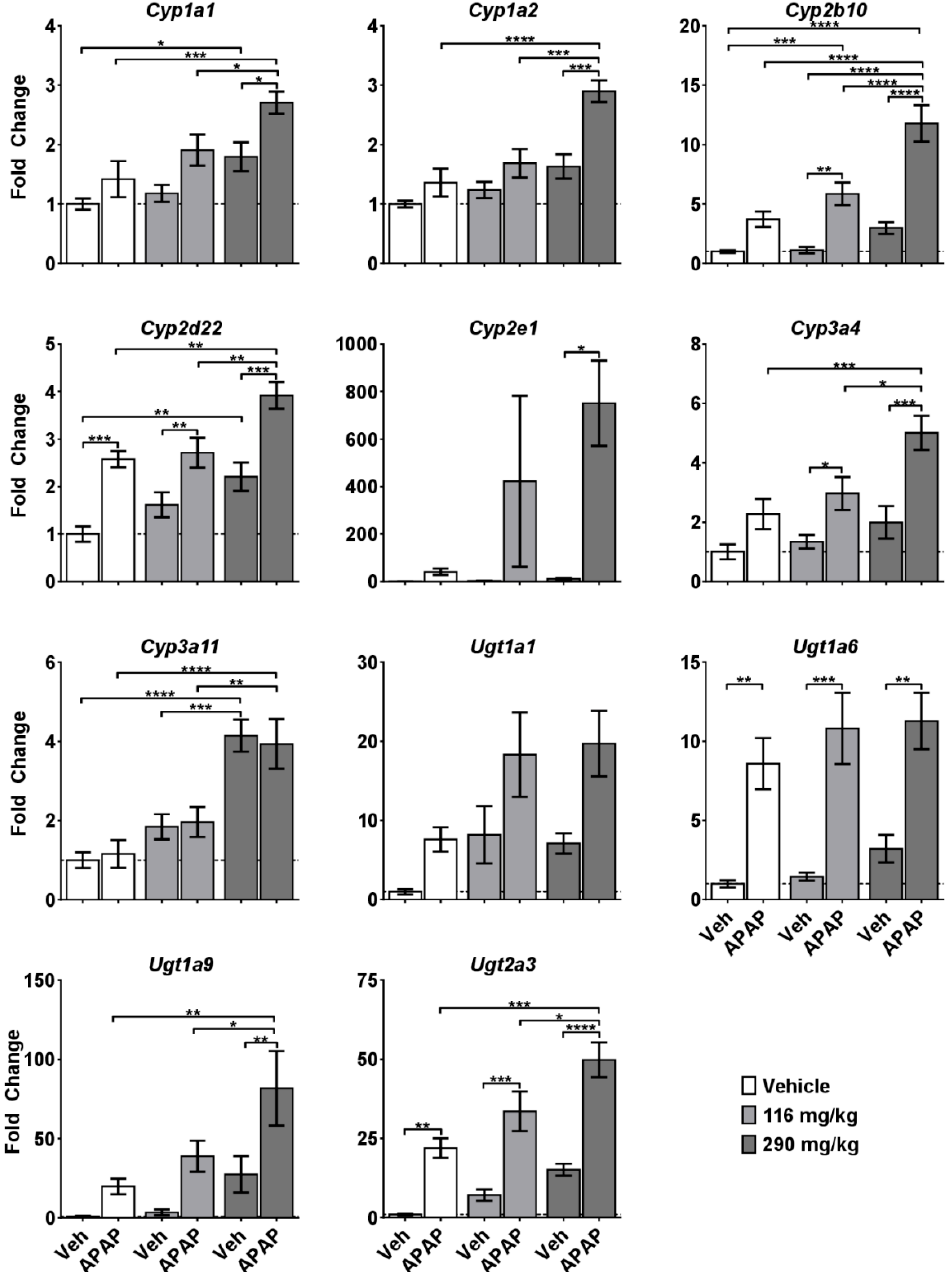
Figure 3. Effects of CRCE/APAP co-administration on intrahepatic expression of cytochrome P450s and UDP-glucuronosyltransferases. Livers were collected 5 h after APAP administration and gene expression was measured using the quantitative real-time (qRT) PCR. Veh ( n = 7); Veh + APAP ( n = 7); 116 mg/kg CBD ( n = 7); 116 mg/kg CBD + APAP ( n = 7); 290 mg/kg CBD ( n = 8); 290 mg/kg CBD + APAP ( n = 8). Data presented as mean ± SEM fold changed from vehicle (* p < 0.05; ** p < 0.01; *** p < 0.001; and **** p < 0.0001). The following genes were changed significantly with either CBD or Ugt1a1 (CBD, p = 0.0186; APAP, p = 0.0255), Ugt1a6 (CBD, p = 0.0222), and Ugt1a9 (APAP, p =